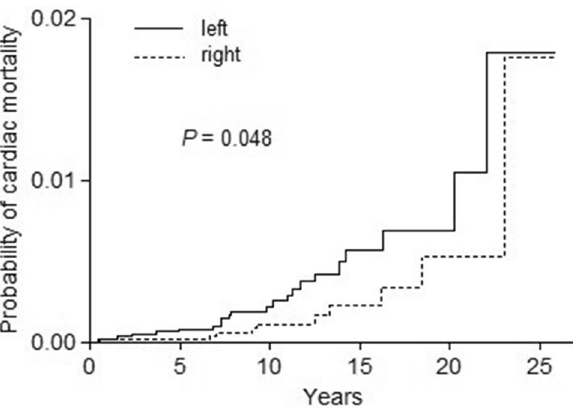
Figure 2. Cumulative incidence of heart-related mortality in young patients aged ≤ 50 years.